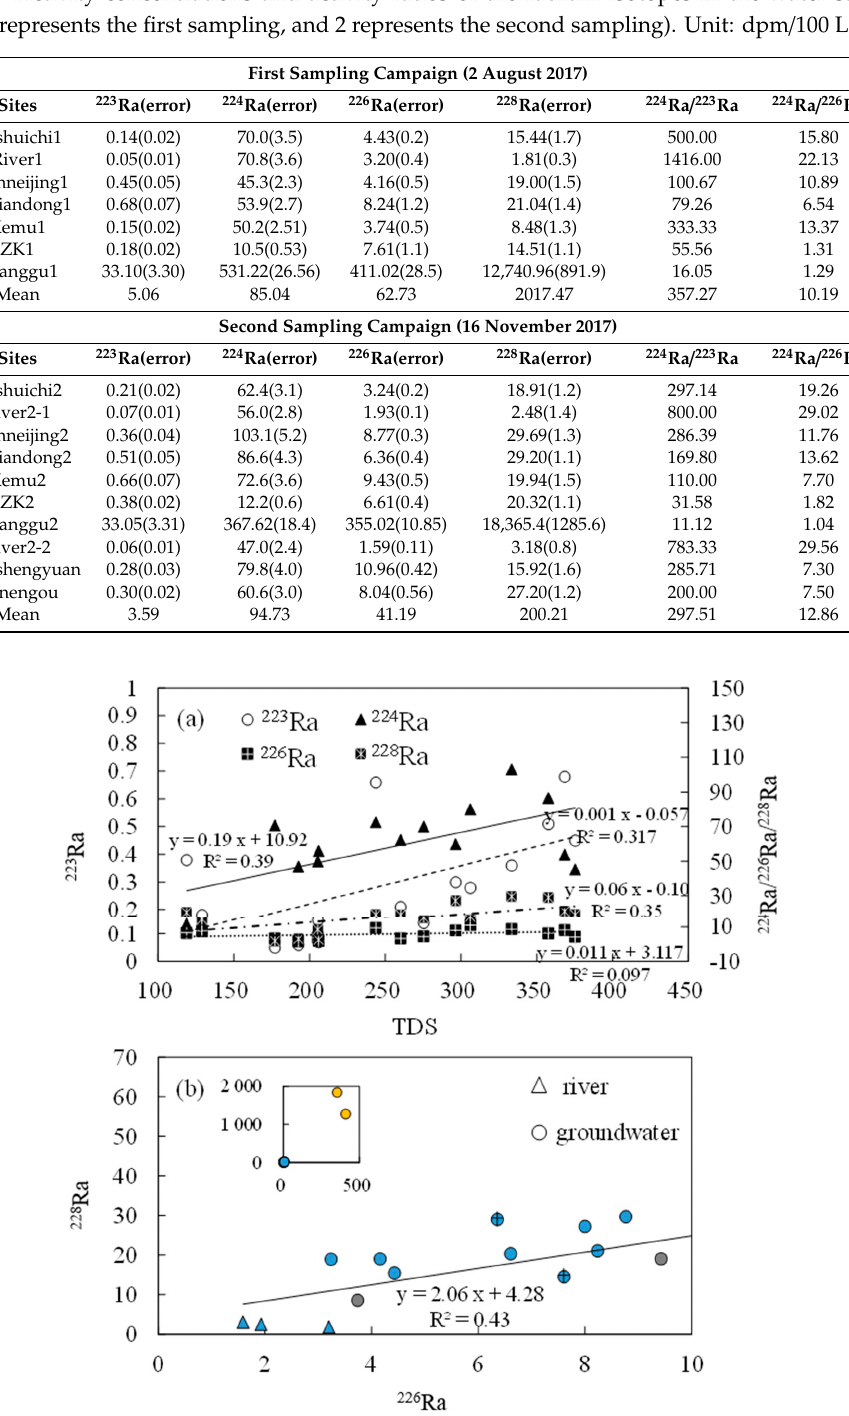
Table 3. Activity concentrations and activity ratios of the radium isotopes in the water samples (note: 1 represents the first sampling, and 2 represents the second sampling). Unit: dpm / 100 L.